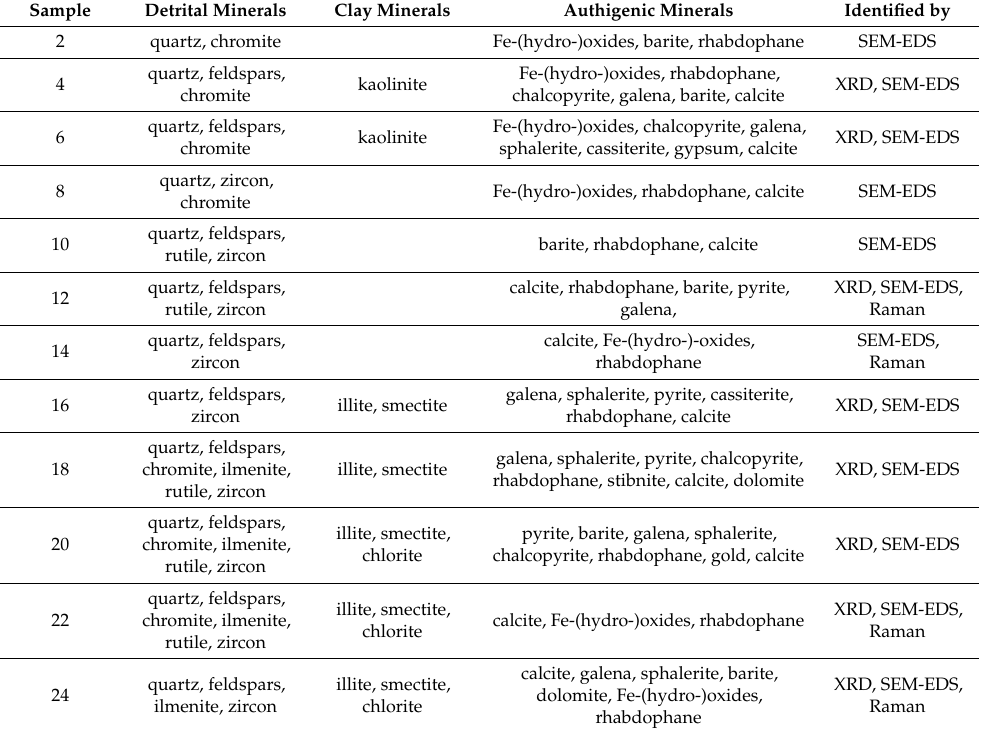
Table 1. Mineralogy of selected samples from Vasygan Swamp, Western